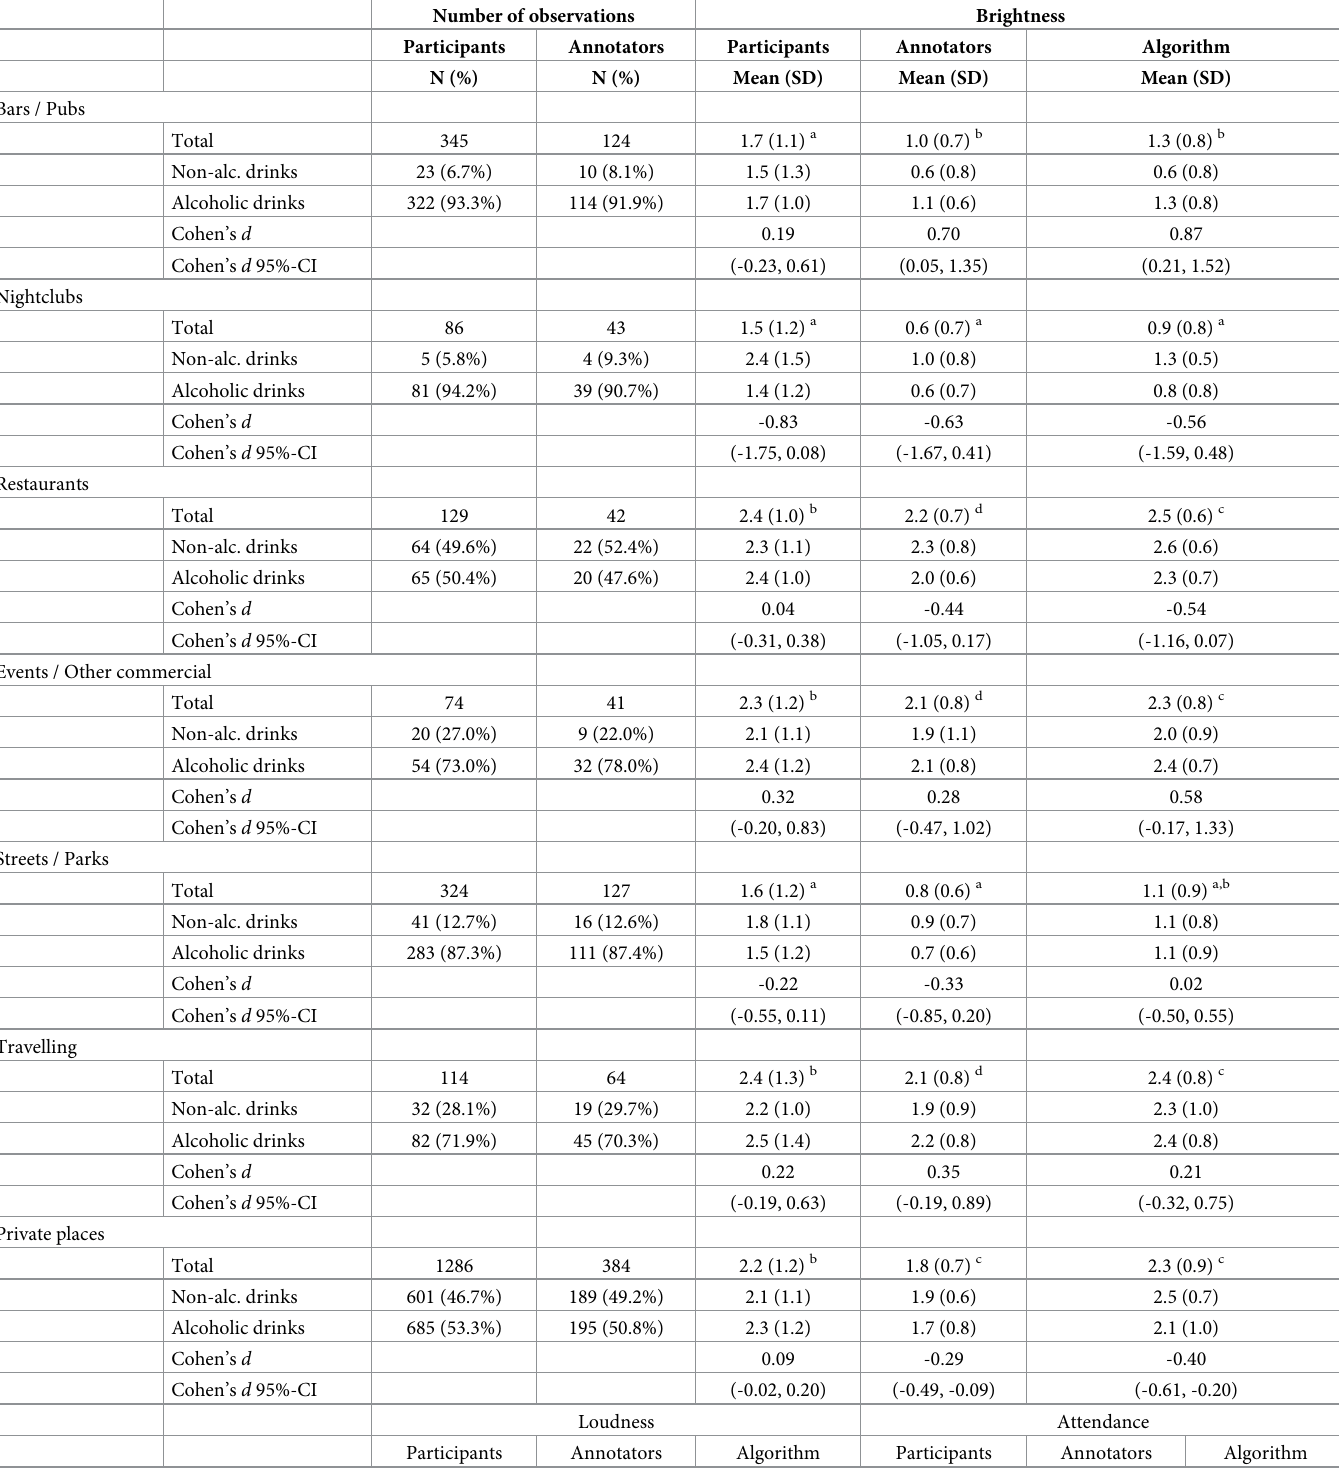
Table 2. Number of situations, and levels of brightness, loudness and attendance, per data source, location type, and type of drink consumed (alcoholic vs. non-